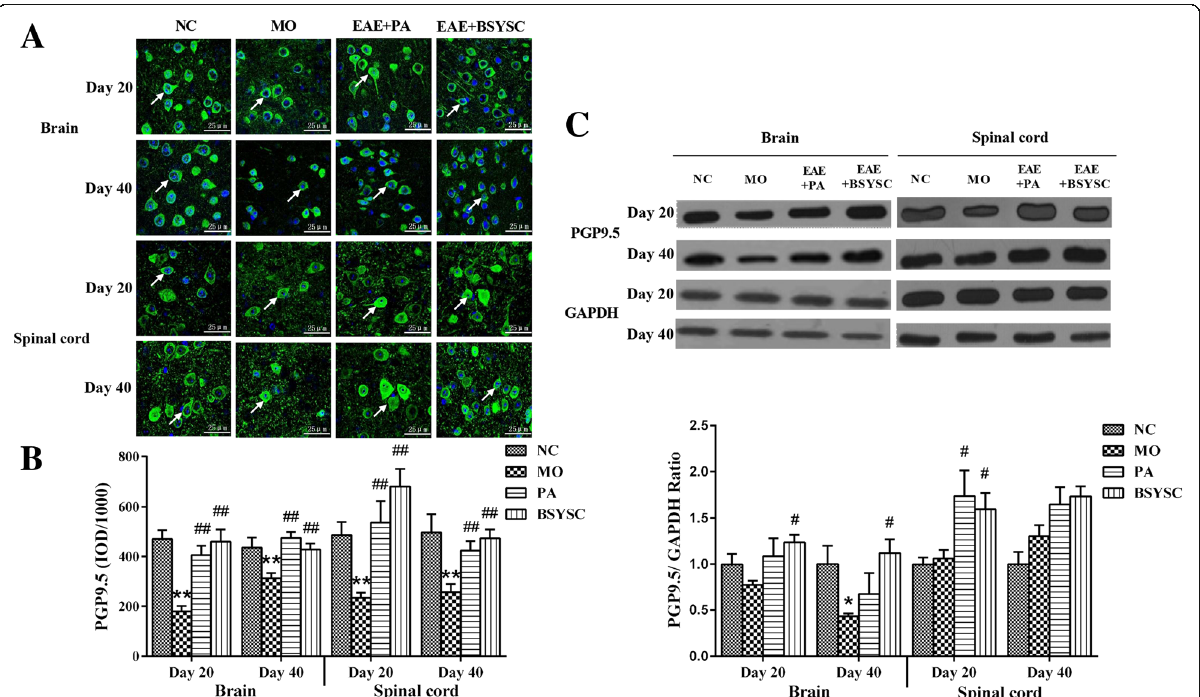
Fig. 1 PGP9.5 protein expression in the brain and spinal cord of mice treated with or without BSYSC 20 and 40 dpi. An increase with different levels in PGP9.5 protein was found by treatment of BSYSC. a The representative immunofluorescent staining of PGP9.5 was shown in each group, the white arrows indicate the positive regions, magnification (×40). b Semi-quantification of integrated optical density (IOD) on PGP9.5 expression was exhibited. c The protein level of PGP9.5 was measured by Western blot and quantified using GAPDH as the loading controls. Data are expressed as means ± SE, n = 5 for each group. * p < 0.05, ** p < 0.01vs. NC; # p < 0.05, ## p < 0.01 vs.